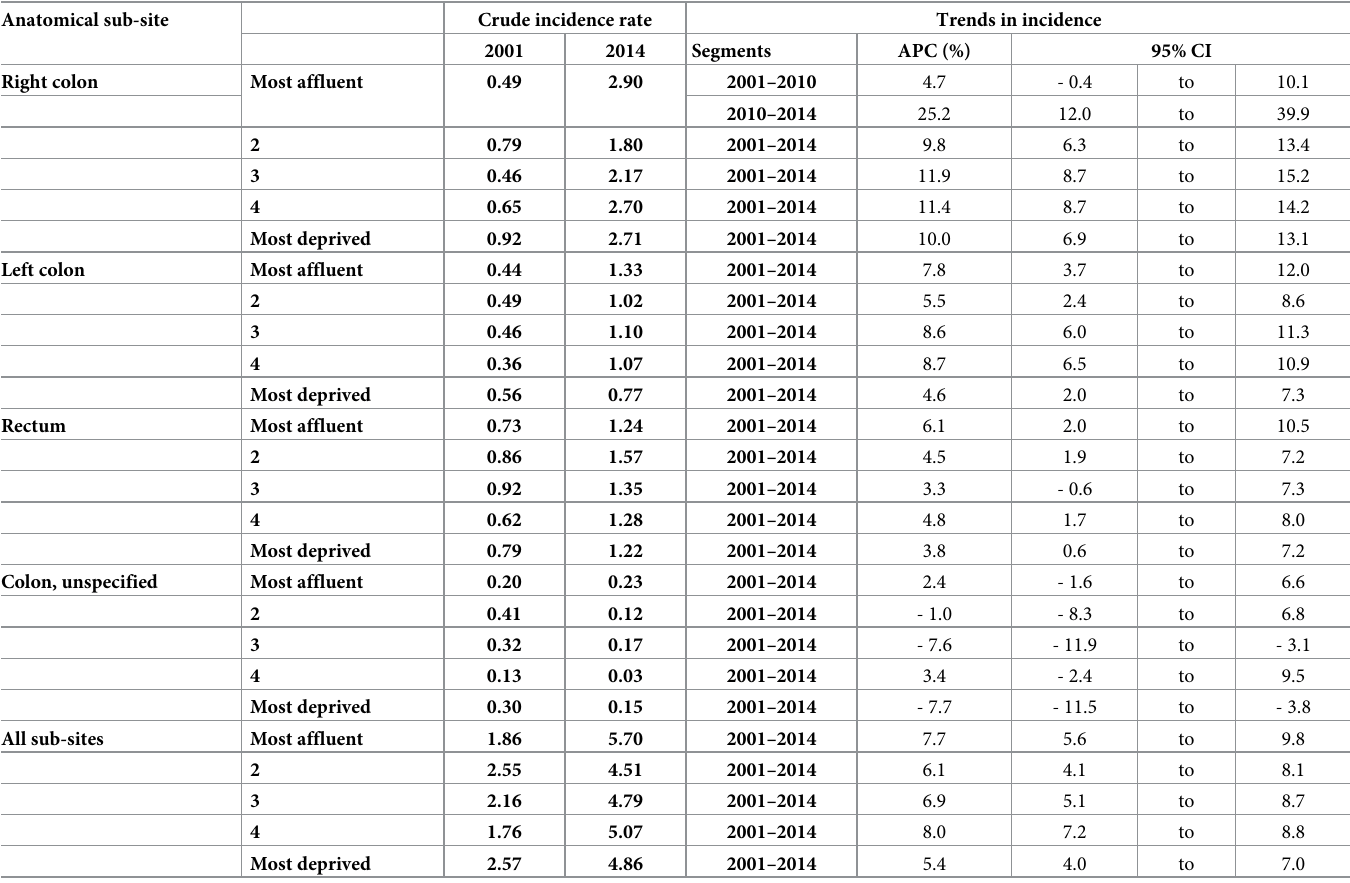
Table 2. Annual Percentage Change (APC) in colorectal cancer incidence rates by anatomical sub-site and deprivation for adults aged 20–39: England, 2001–2014. Anatomical sub-site Crude incidence rate Right colon